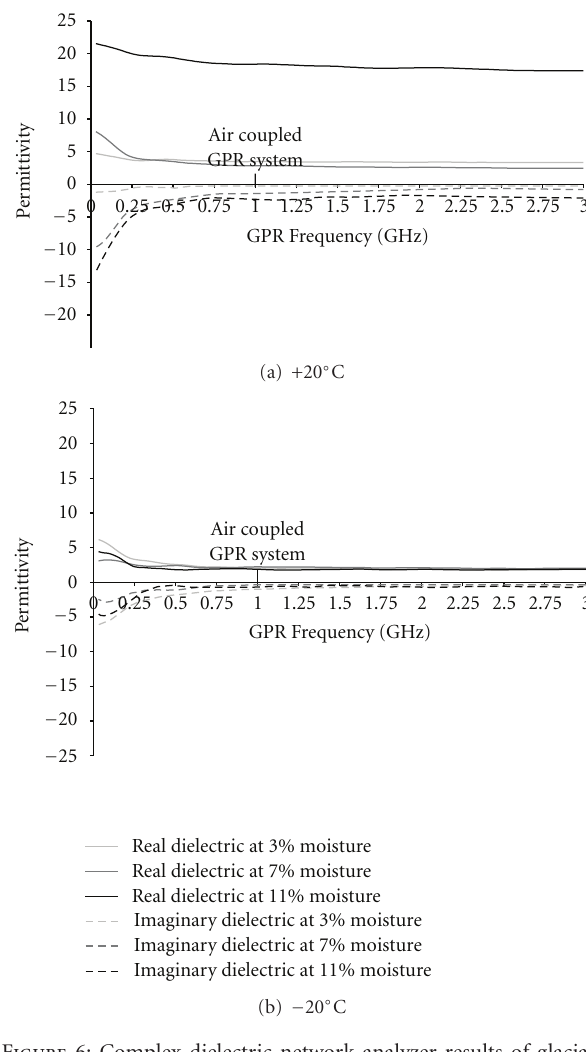
Figure 6: Complex dielectric network analyzer results of glacial- alluvium gravel